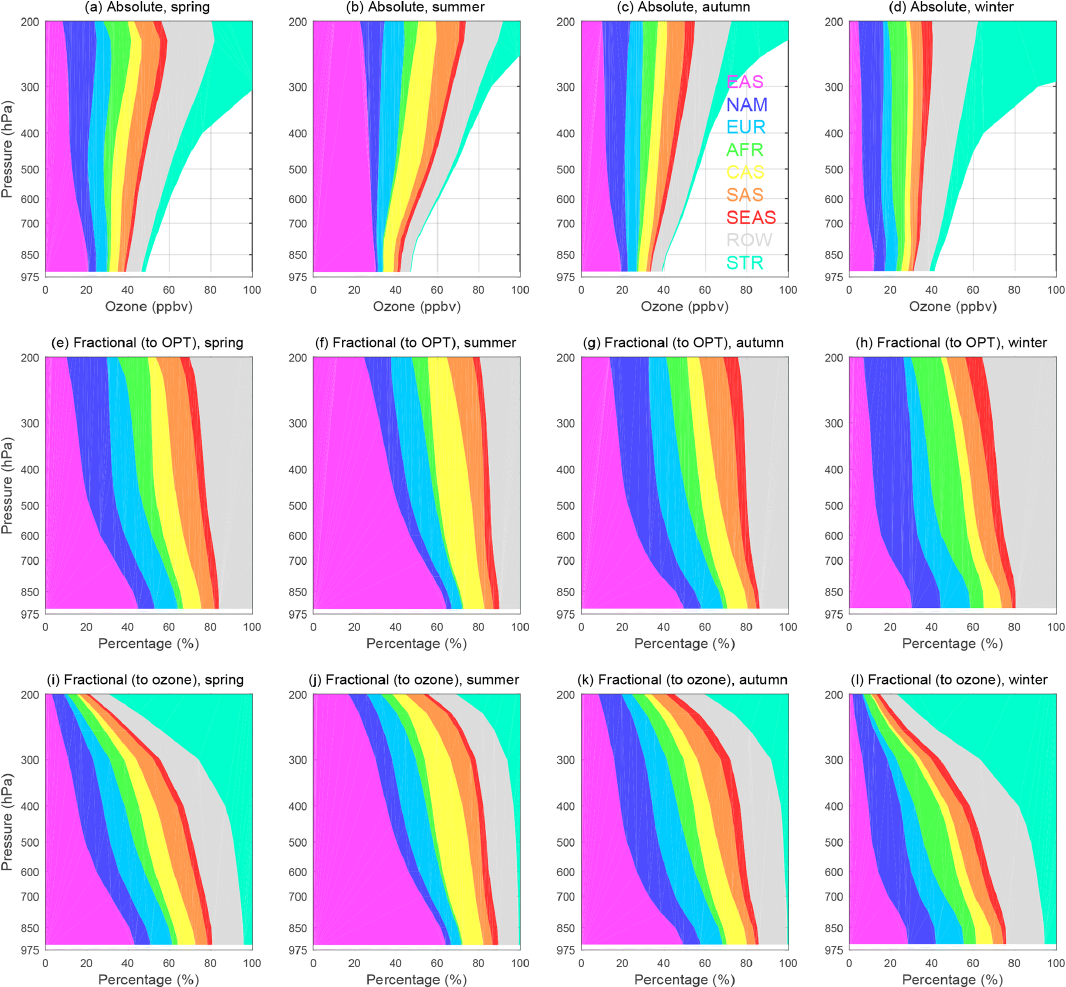
Figure 9. ( a – d ) Vertical variations in ozone (in ppbv) from native and foreign sources over East Asia by season. ( e – h ) The same as ( a – d ) but in terms of the factional contributions (in %) to ozone produced in the troposphere (OPT). ( i – l ) The same as ( a – d ) but in terms of the fractional contributions (in %) to ozone over East Asia. All values are the means over East Asia at each altitude in 2005. The abbreviations are for East Asia (EAS), North America (NAM), Europe (EUR), Africa (AFR), central Asia (CAS), South Asia (SAS), South-east Asia (SEAS), the rest of the world (ROW), and the stratosphere